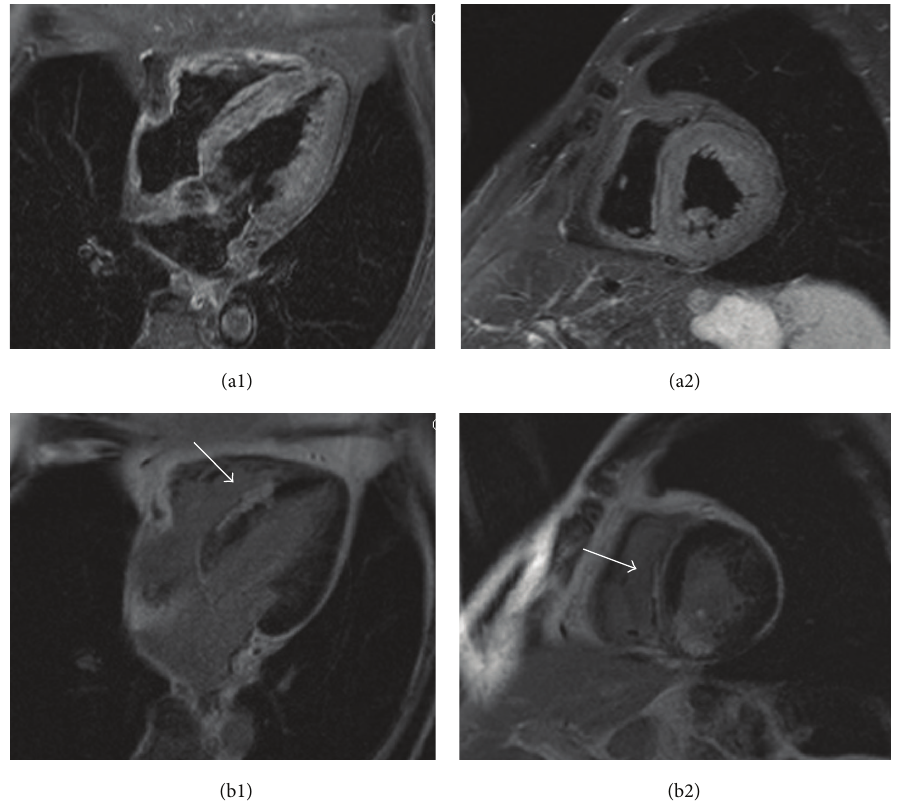
Figure 9: CMR at 4 months later demonstrated resolution of the hematoma with epicardial LGE. (a) T2-weighted image. (b) LGE